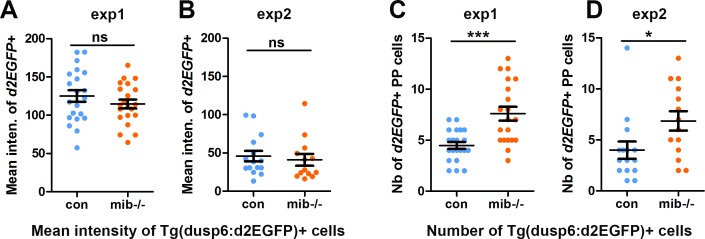
The number but not the mean intensity of Tg(dusp6:d2EGFP) expressing cells is increased in mib-/- mutants.(A–B) Dot plots showing the mean GFP fluorescence intensity (A, B) of Tg(dusp6 :d2EGFP) expressing parapineal cells in the first (A) and second experiment (B) in controls (blue dots; A, n = 21; B, n = 15) or in mib-/- mutant embryos (orange dots; A, n = 21; B, n = 13) at 32 hpf stage; data are presented separately for the two experiments as the mean intensity threshold chosen to define Tg(dusp6 :d2EGFP)+ cells (See Materials and methods) differ between both experiments. (C–D) Dot plots showing the number of Tg(dusp6:d2EGFP) expressing parapineal cells in the first (C) and second experiment (D); merged data for both experiments are presented in the main manuscript as Figure 1E.